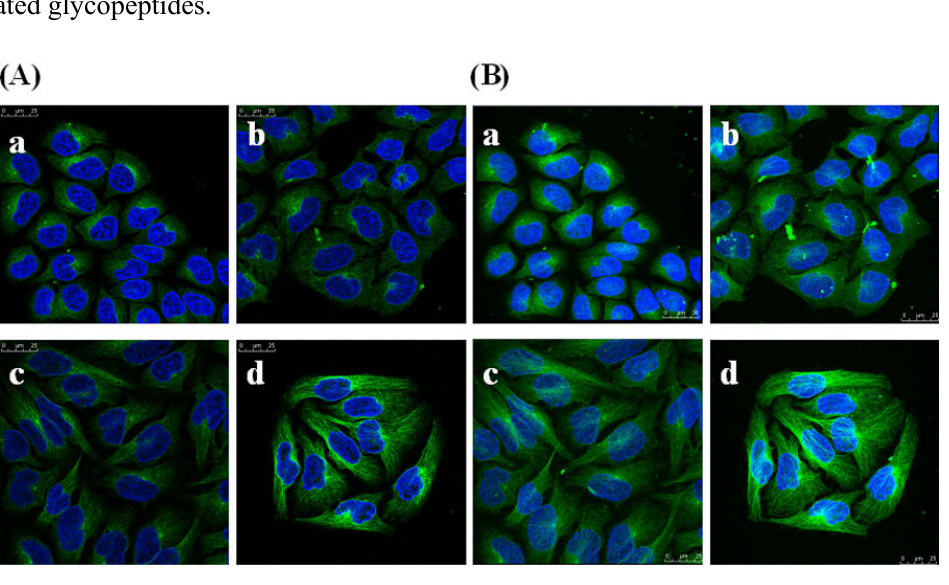
Figure 9. Effect of Gekko sulfated glycopeptides on the microtubules of SMMC-7721 cells. Cells were first incubated with antibody against microtubules and then fluorescence-conjugated secondary antibody against the first antibody, followed by staining with 4’,6-diamidino-2-phenylindole and photography. Then the cells were photographed under oil microscope (600×). ( A ) Sectional images (on the left); ( B ) 3-dimensional images (on the right). ( a ) Control group; ( b ) 10 µg/mL Gekko sulfated glycopeptides; ( c ) 100 µg/mL Gekko sulfated glycopeptides and ( d ) 200 µg/mL Gekko sulfated